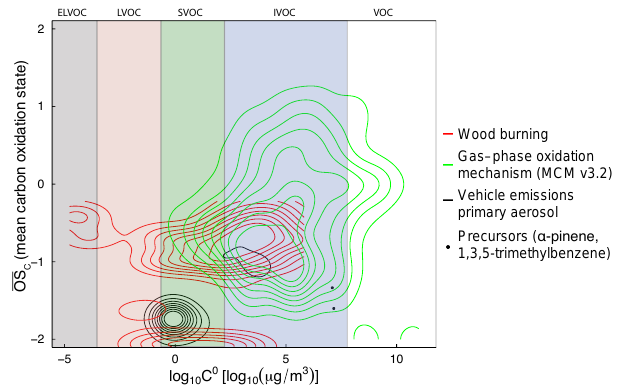
Figure 4. Test for the uniqueness of matching for each atom. Num- ber of times a specific atom has been matched in the α -pinene and 1,3,5-trimethylbenzene degradation scheme in MCMv3.2 by the SMARTS patterns in Table 1, substructures 1–33. Oxygen, nitro- gen, and hydrogen atoms are matched only once. The carbon atoms are matched multiple times when multifunctional.